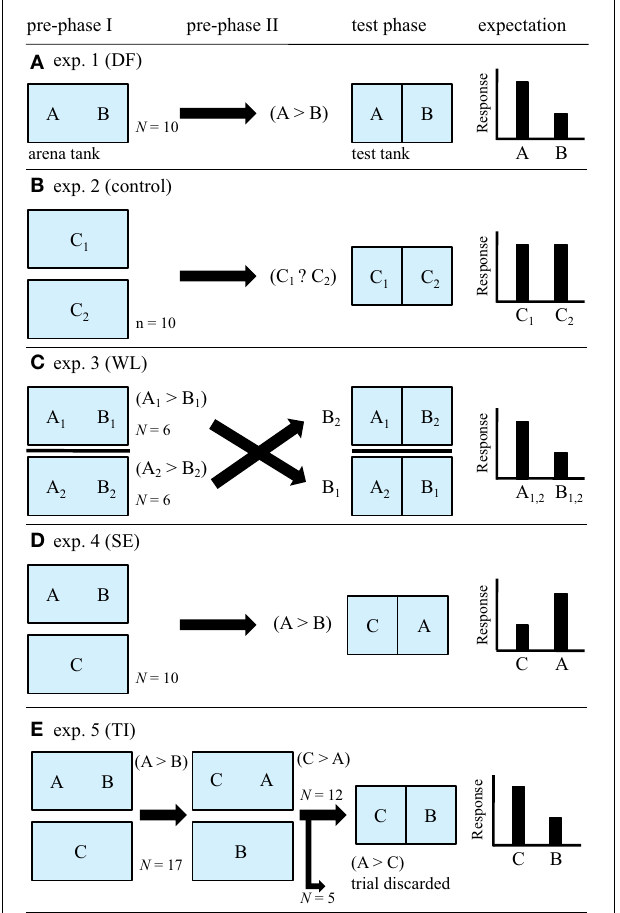
FIGURE 2 | Design of the experiments. All five experiments contained pre-phase I (and II if needed) and test phase. The expected responses (rushing time or time spent near the opponent, see text) are shown at the right when the predictions from the different hypotheses tested are supported. (A) Experiment 1 A and B had a direct encounter during the pre-phase and re-establish dominance during the test phase. (B) Experiment 2 C 1 and C 2 had only visual contact in the pre-phase and establish dominance during the test phase. (C) Experiment 3 (testing winner/loser effects). A1 and A2 dominated B1 and B2 in arena tank, respectively. If A 1 and A 2 dominate against B 2 and B 1 against glass barrier in test phase, respectively, the loser-winner effect will operate. (D) Experiment 4 (testing eavesdropping hypothesis). Fish C observed interactions A > B. If the fish C exhibited submissive behaviors against A, but if it exhibited aggressive behaviors against B, the prediction from eavesdropping hypothesis will be supported. (E) Experiment 5 (testing transitive inference hypothesis). Fish C observed interactions A > B, thereafter B observed interactions C > A. According to the transitive-inference hypothesis, fish C is expected to dominate over fish B against glass